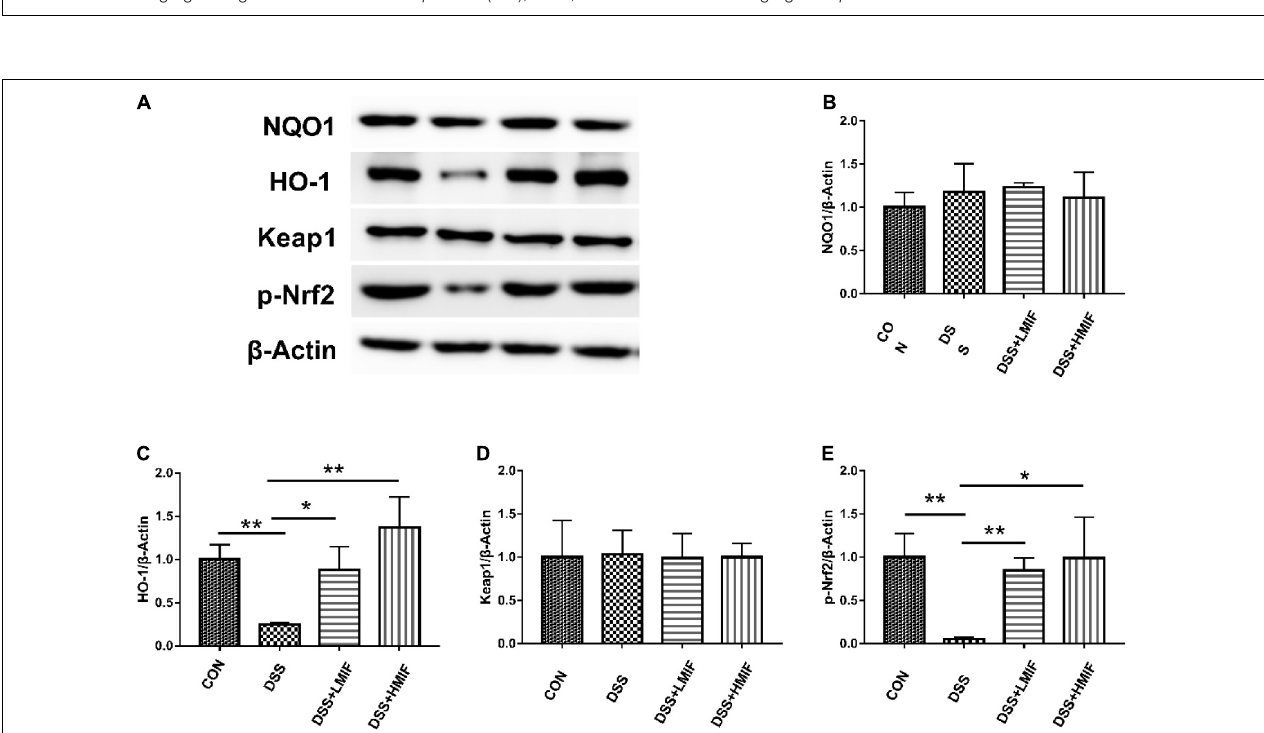
FIGURE 3 | Effects of Morchella importuna flavones on the abundances of the colonic Nrf2 signaling pathway-related proteins in dextran sulfate sodium (DSS)-challenged mice. (A) Representative Western blot picture; (B) NAD(P)H dehydrogenase (quinone 1) (NQO-1); (C) heme oxygenase-1 (HO-1); (D) Keap1; (E) p-Nrf2. CON, control; DSS, DSS treatment; LMIF, DSS treatment + 100 mg/kg fruiting bodies of Morchella importuna (MIF); HMIF, DSS treatment + 200 mg/kg MIF. * p < 0.05 or ** p < 0.01.